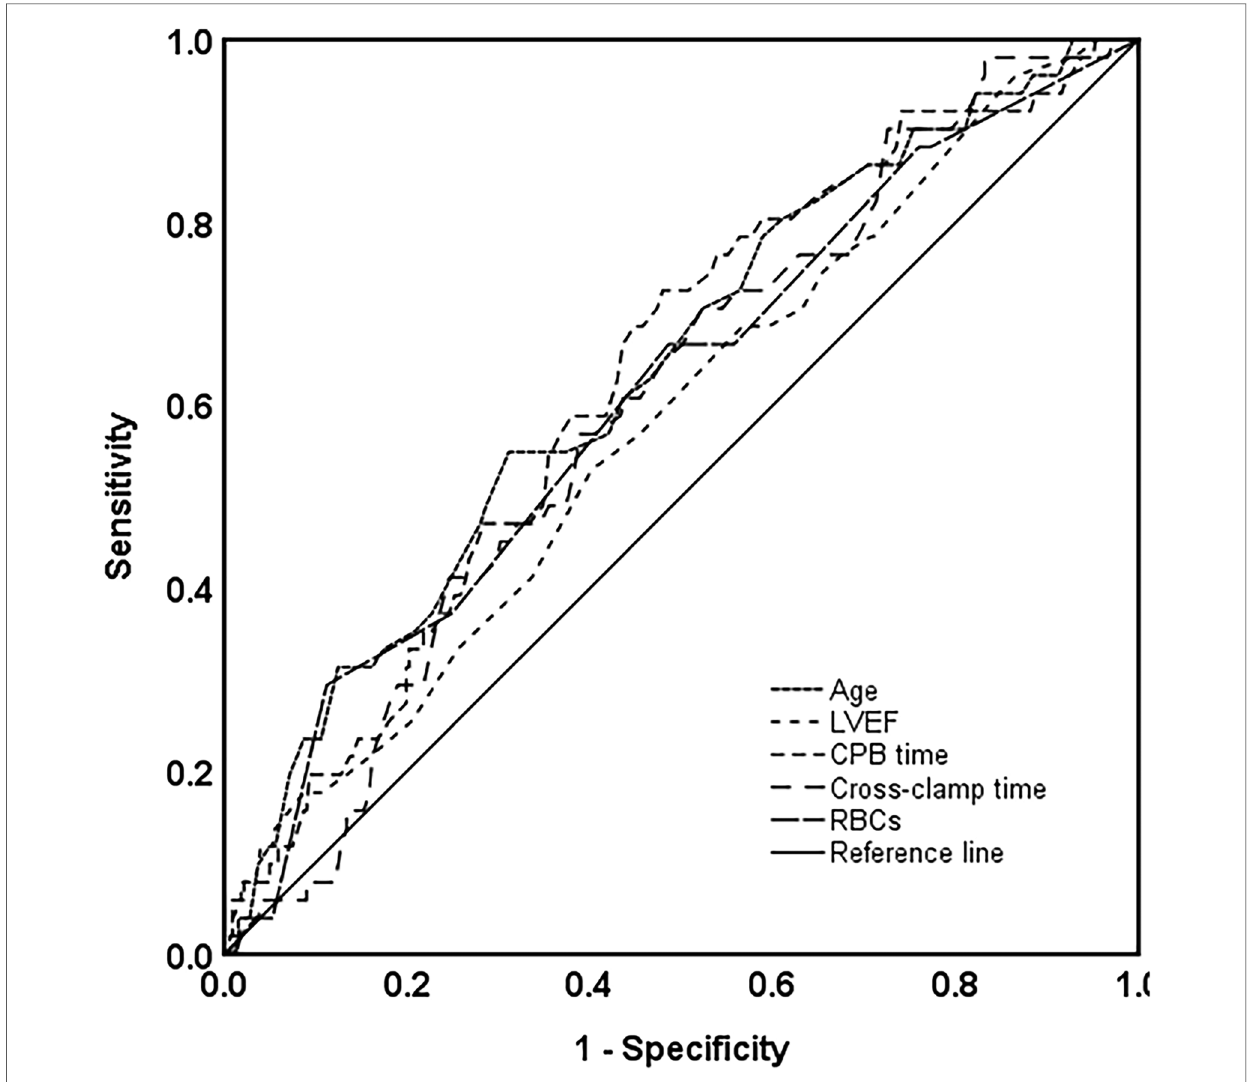
FIGURE 1 Survival prediction with ROC analysis based on age, LVEF, CPB, and cross-clamp time and intraoperative RBC transfusion. ROC, receiver operating characteristic; LVEF, left ventricular ejection fraction; CPB, cardiopulmonary bypass; RBCs, red blood cells.